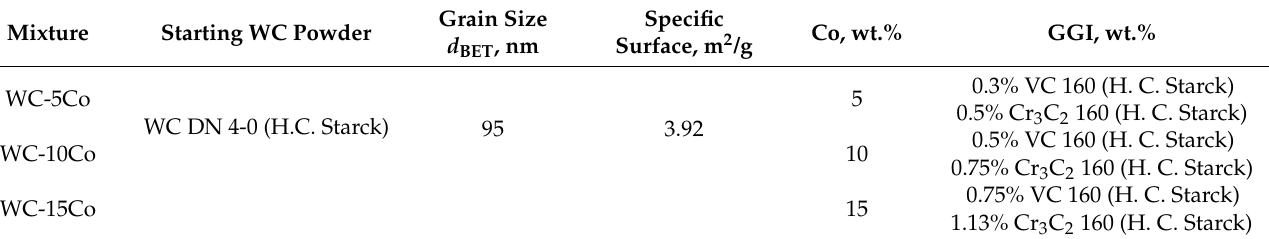
Table 1. The characteristics of the starting